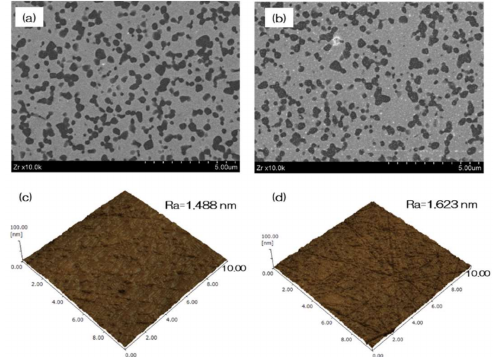
Figure 1. The surface characterization of NANOZR samples. In the scanning electron microscopy (SEM) evaluation, no change was observed on the surface of the NANOZR by UV treatment ( a —test; b —control). Scanning probe microscopy (SPM) analysis also showed no change in the surface roughness of the test disks ( c —test; d —control).